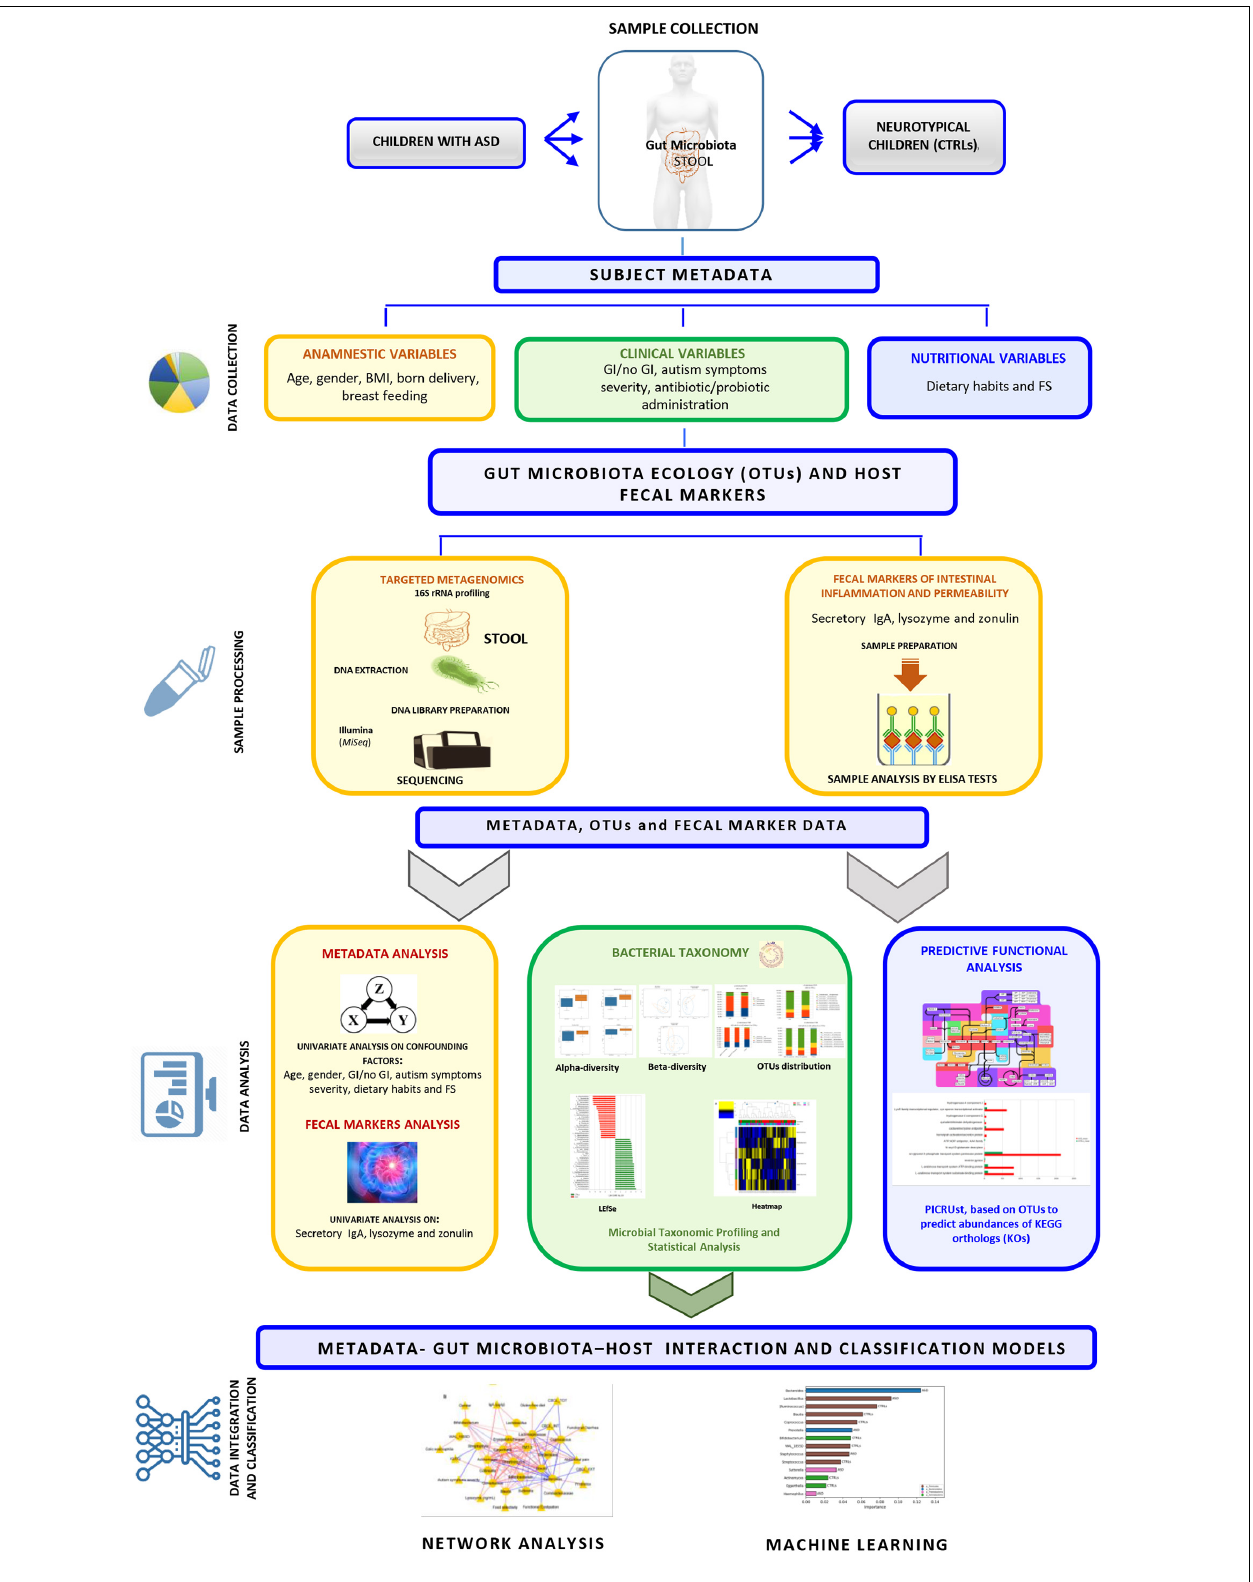
FIGURE 1 | Graphical representation of the experimental workflow performed in the study.